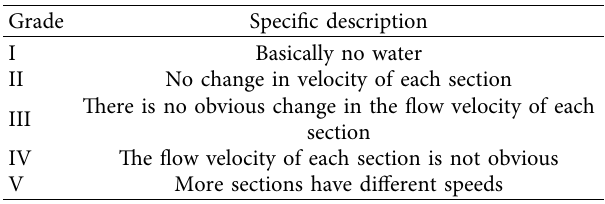
Table 2: Classification standard of flow rate index.